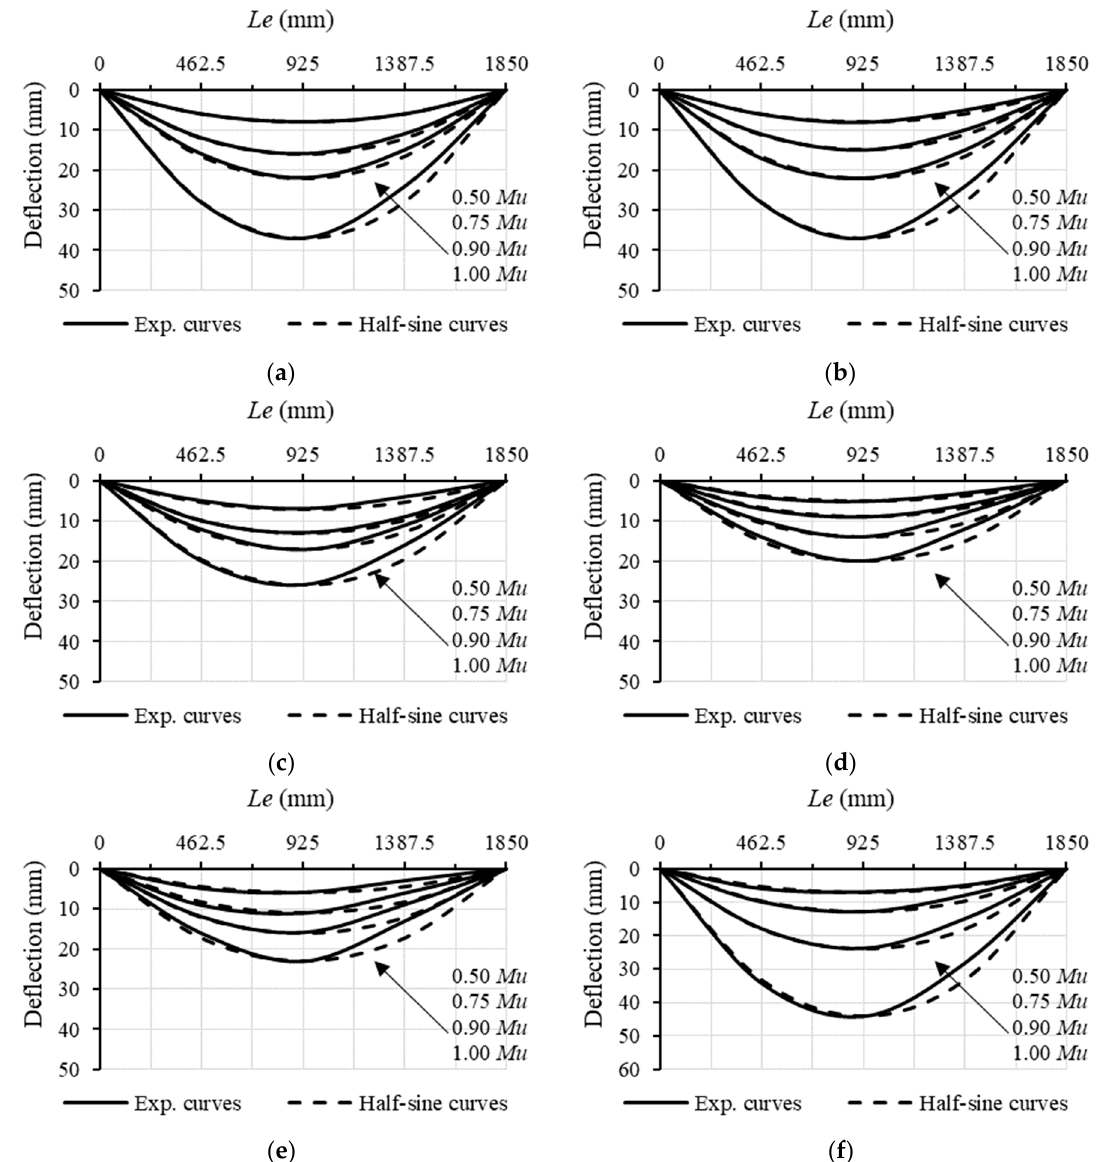
Figure 8. Typical strengthening behavior of RCFSST specimens with/without CFRP; ( a ) MC0; ( b ) MC50; ( c ) MC100; ( d ) MC100-N; ( e ) MC100-N-1CFRP; and ( f ) MC100-N-3CFRP.